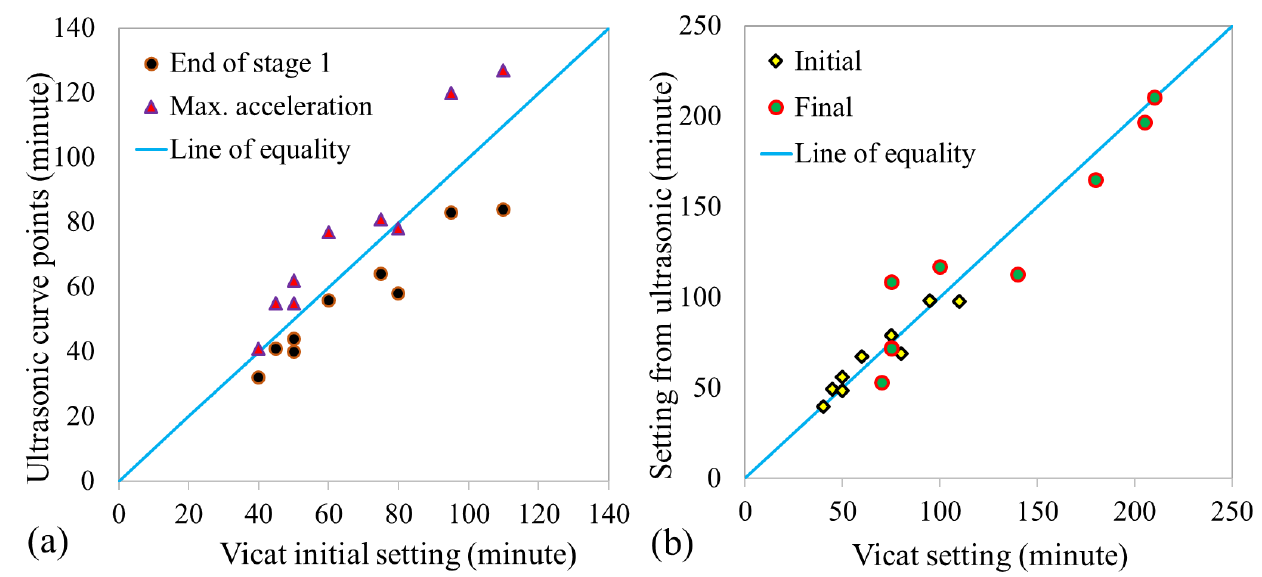
Figure 5. Correlation of setting time measurements ( a ) Vicat initial setting time and ultrasonic curve points, ( b ) Setting times from Vicat and equations.